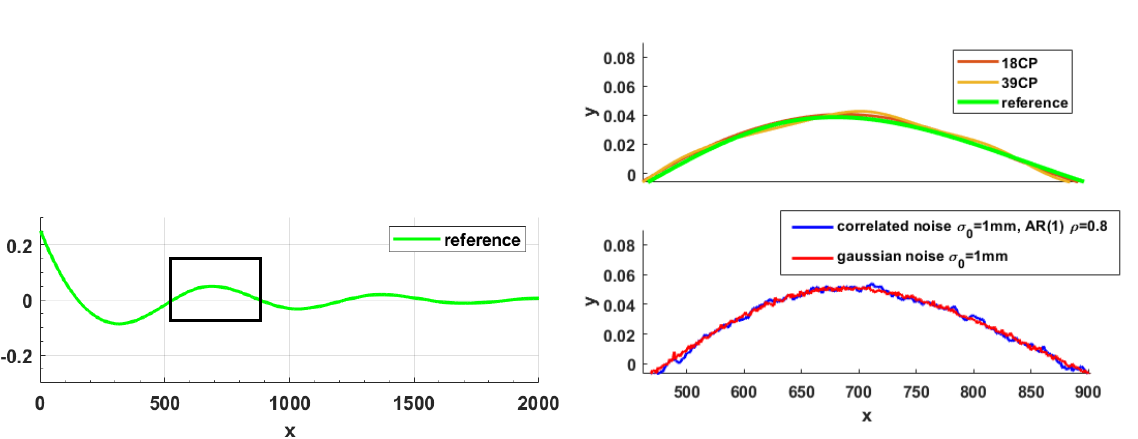
Fig. 3. Left: reference curve used for the simulations. Right down: zoom into the noisy curve corresponding to the black box. Correlated noise AR(1) with ρ = 0.8 (blue) and Gaussian noise (red) were added to the reference curve. The noise variance factor was fixed to σ 2 = 1mm 2 . Right top: zoom into the fitted curves for different number of CP. number of CP, only the penalty terms (model misspecifi- cation and complexity) differ for the generalized IC (HC, HAC, and KLD